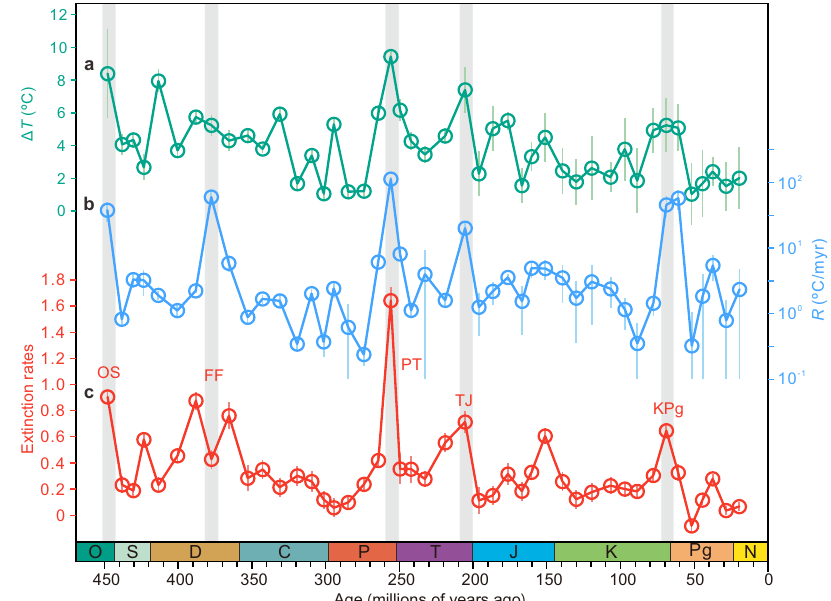
Fig. 1 Temperature change and extinction rate over the past 450 million years. a The largest magnitude of temperature change ( Δ T , absolute value) in each time bin. b The highest rate ( R , absolute value) of temperature change in each time bin, de fi ned at the million-year (Myr) scale. c Generic extinction rates of marine animals calculated using gap- fi ller methods using data from the Paleobiology Database. The Big Five extinctions occurred in the end- Ordovician (OS), Frasnian-Famennian transition (FF), Permian-Triassic transition (PT), Triassic-Jurassic transition (TJ), and Cretaceous-Paleogene transition (KPg). Vertical bars show mean ± 1 x standard deviation (see Methods). O Ordovician, S Silurian, D Devonian, C Carboniferous, P Permian, T Triassic, J Jurassic, K Cretaceous, Pg Paleogene, N Neogene. Dark cyan, blue, and red dots represent Δ T , R , and extinction rate, respectively. Source data are provided as a Source Data fi